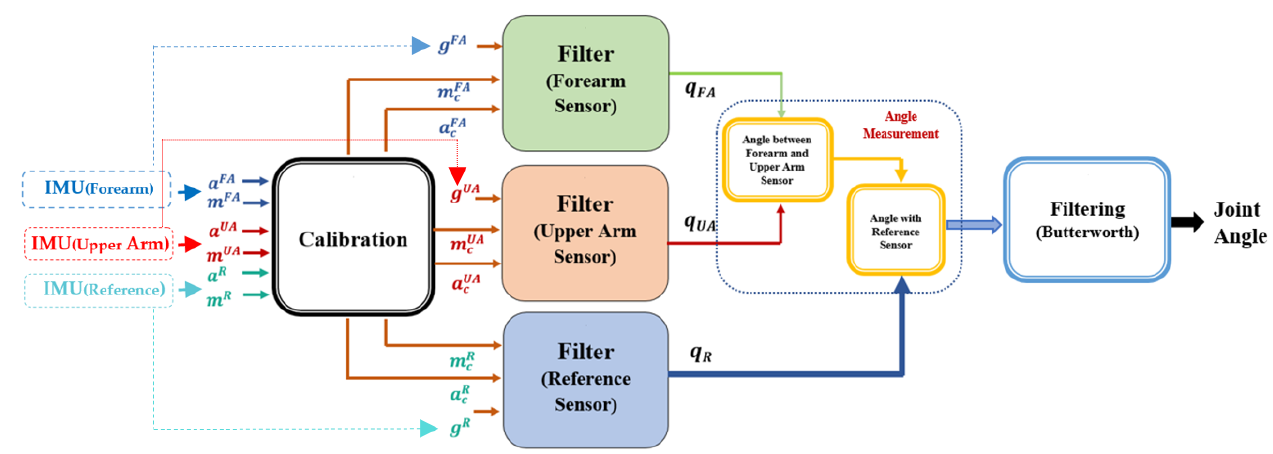
Figure 2. Proposed algorithm for joint angle estimation.